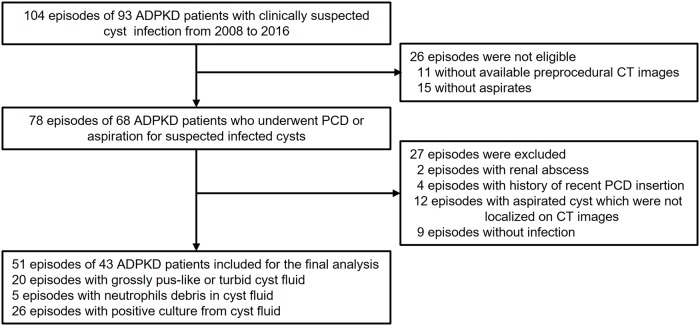
Flowchart for inclusion and exclusion of patients.Note: ADPKD = autosomal dominant polycystic kidney disease; PCD = Percutaneous catheter drainage.